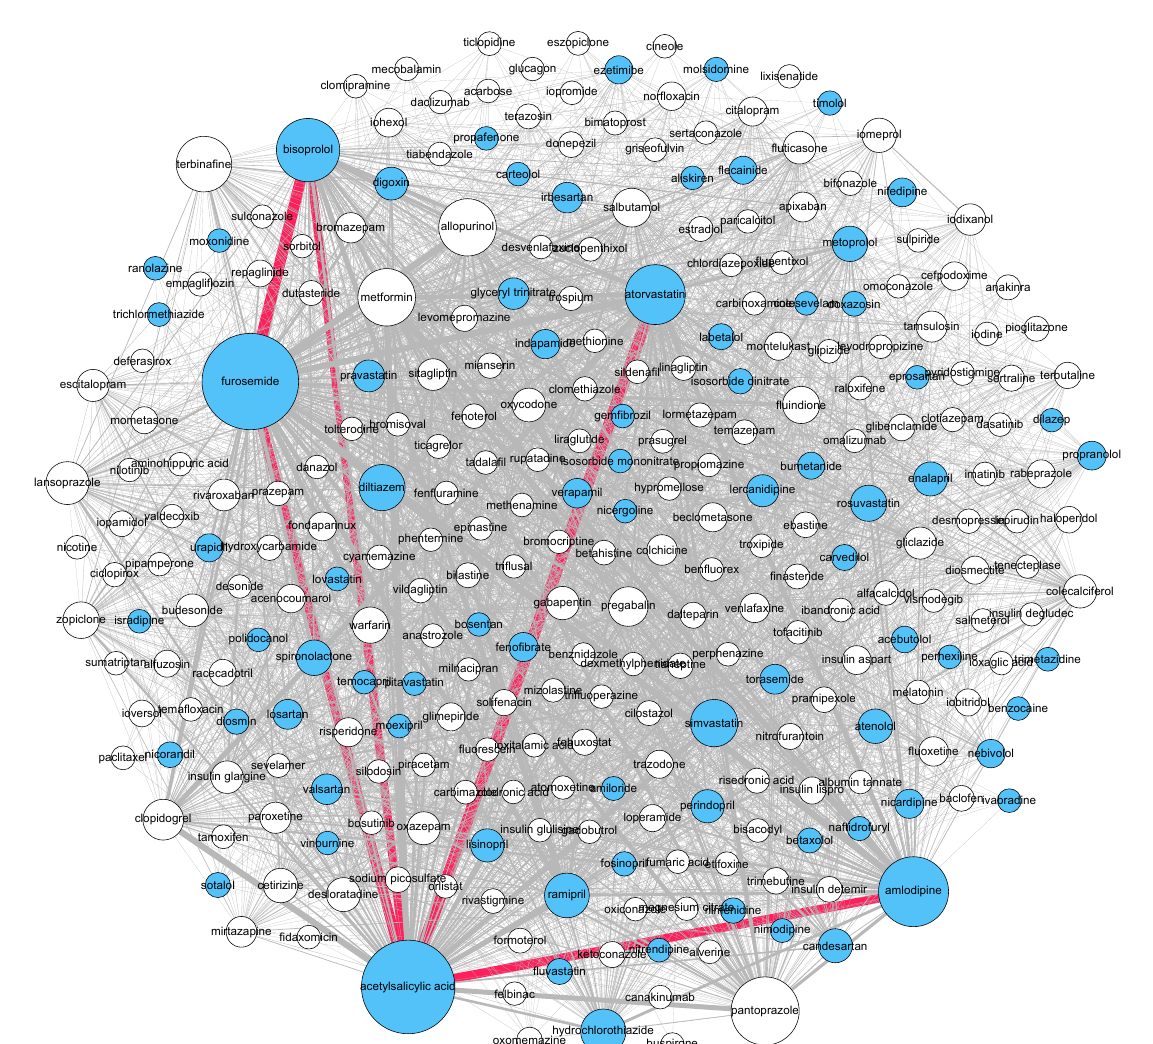
Figure 2. Cluster 2 (cardiovascular cluster) with cardiovascular drugs highlighted in blue, and most relevant edges highlighted in red. Nodes represent medications, the sizes of the nodes are proportional to the prevalence of the drug, the links indicate that the two connected drugs were taken concomitantly, the width of the link is proportional to the number of times the pair of drugs was reported.